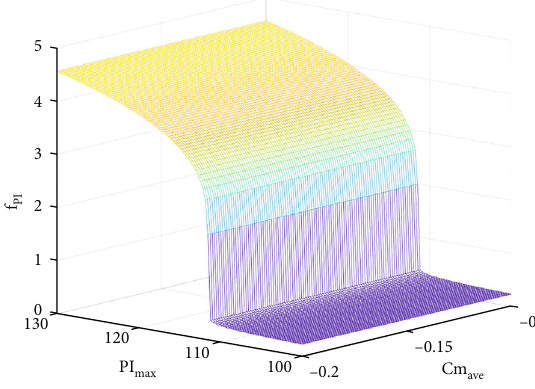
Figure 1: Power factor term.